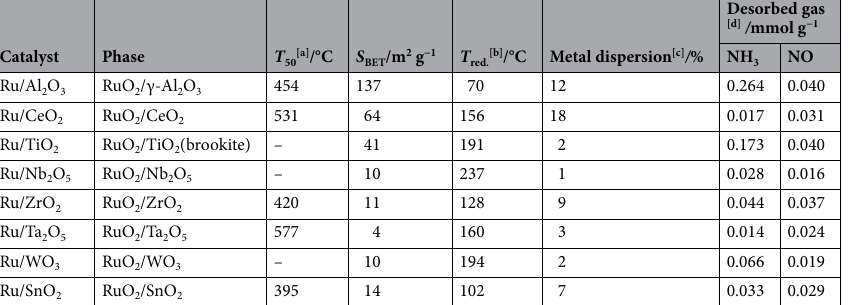
Table 1. Catalytic properties of 5.0 wt% Ru supported on various different oxide materials. [a] Temperature at which N 2 O conversion reached 50%. [b] Temperature of the first H 2 consumption peak determined by H 2 - TPR. [c] Calculated with the stoichiometric adsorption of CO on Ru in a ratio of CO:Ru = 1:1. [d] Estimated using NH 3 - and NO-TPD in the temperature range of 100–500